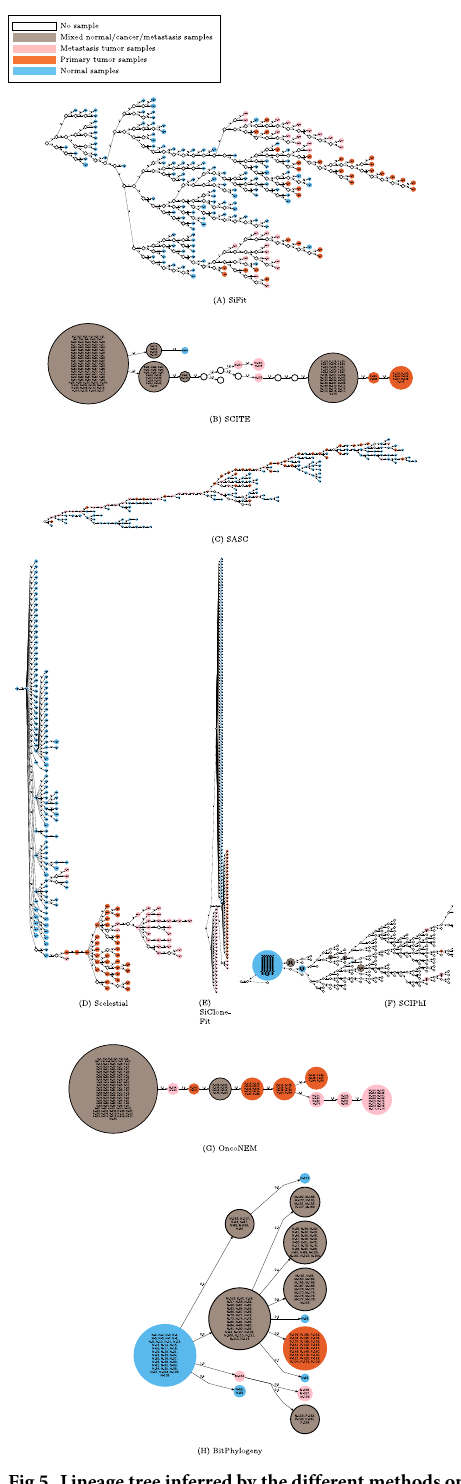
Fig 5. Lineage tree inferred by the different methods on a single-cell dataset from the first colorectal cancer patient.